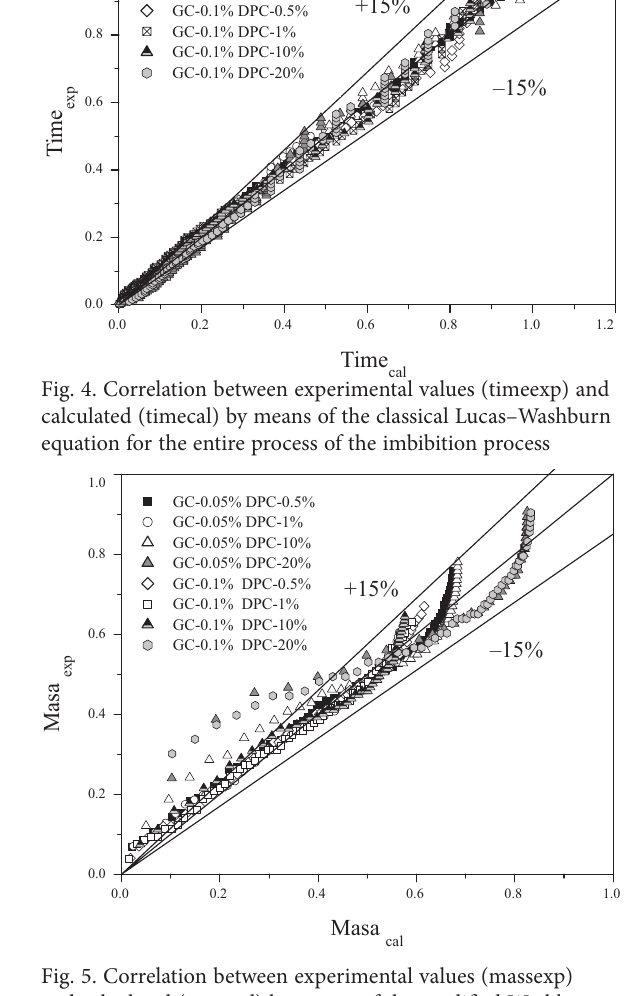
Fig. 2. Correlation between experimental values (timeexp) and calculated (timecal) by means of the classical Lucas–Washburn equation for the first phase of the imbibition process